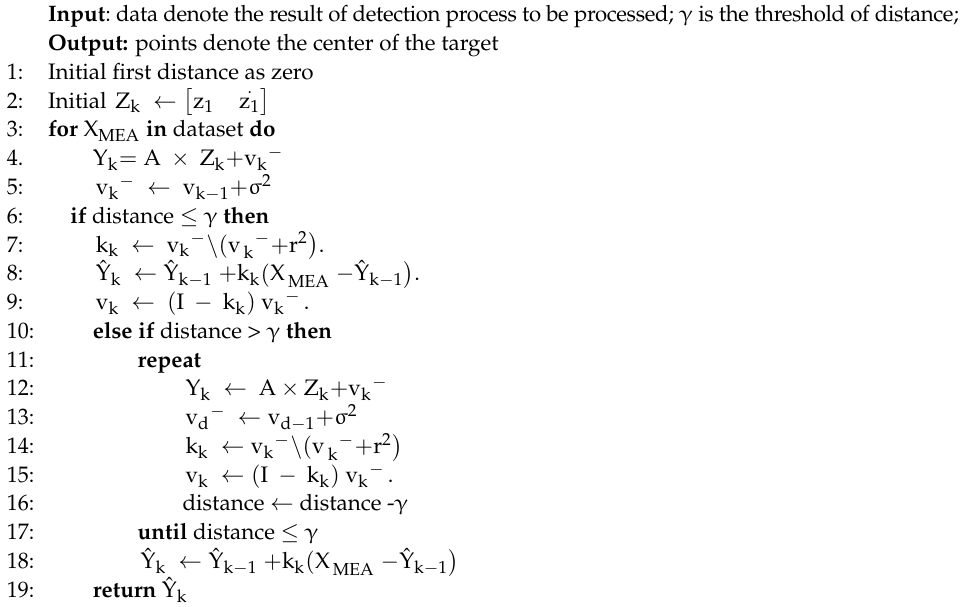
Algorithm 2: Trajectory Optimization based on the Kalman